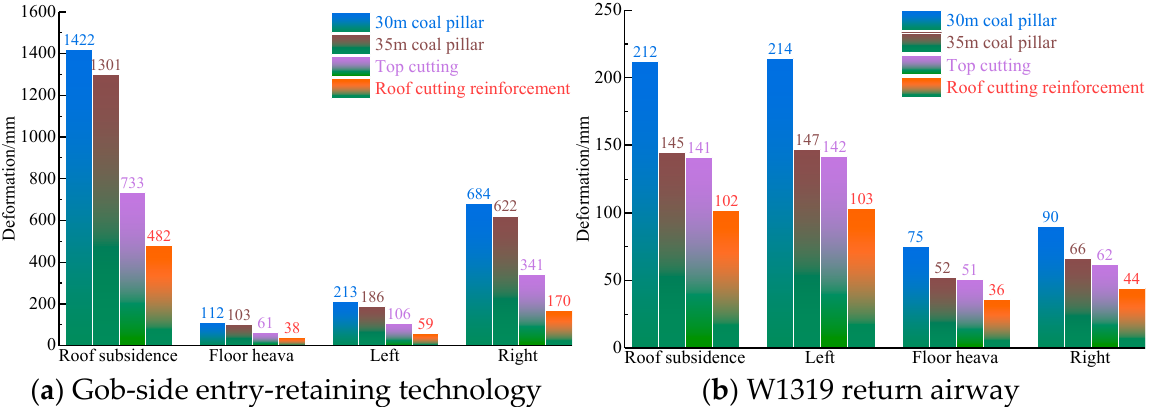
Figure 19. Deformation statistics of surrounding rocks of the roadway.